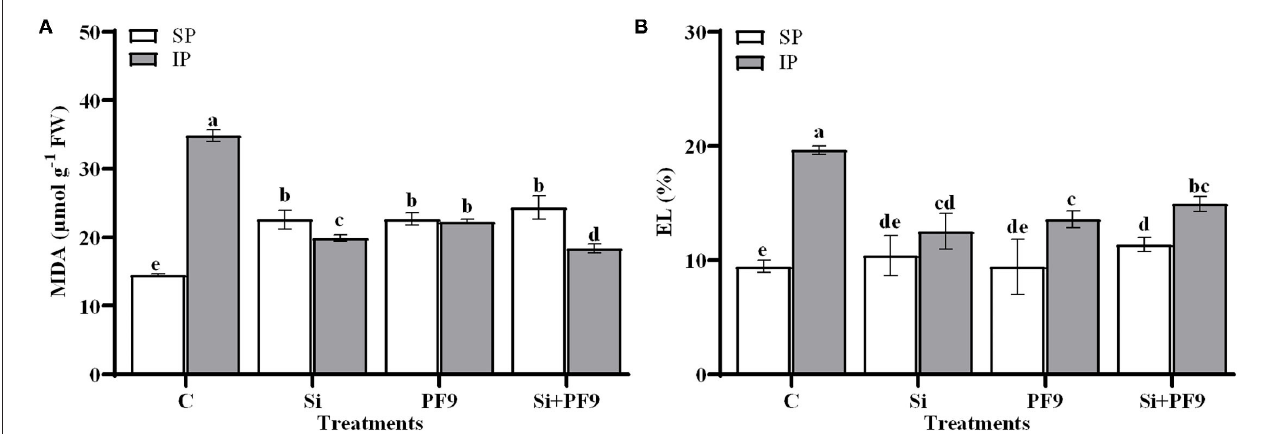
FIGURE 2 | Effect of 3mM Si treatment and PF9 strain inoculation on malondialdehyde (MDA) (A) and electrolyte leakage (EL) (B) of Medicago sativa ( OL population) plants grown under 250 µ mol of either soluble (KH 2 PO 4 ) (SP) or insoluble (Ca 3 HPO 4 ) (IP) phosphorus conditions. Values are means of three replicates and error bars are SD. Different letters indicate significant difference at p <